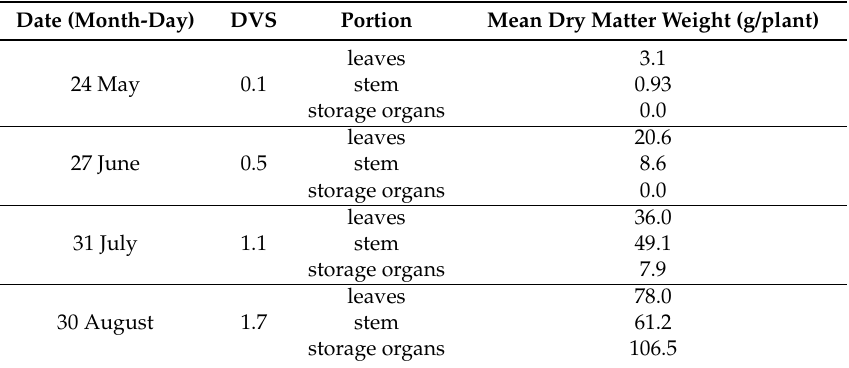
Table 2. Dry matter weight of observation Area 2.